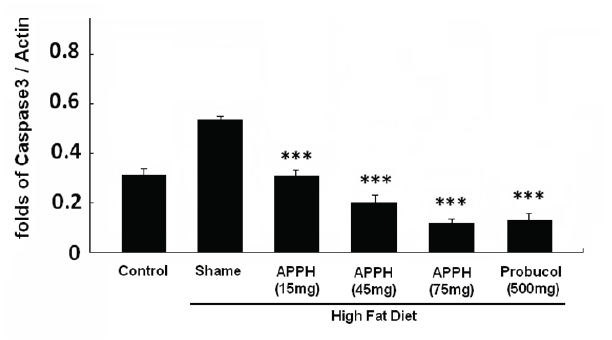
Figure 3. Fas-induced apoptosis pathway signaling analysis. All protein samples from each rat group were analyzed by Western blotting ( n = 3). The protein expression folds were normalized with β -actin. * p < 0.05, ** p < 0.01, *** p < 0.001 compared with the HFD (high-fat diet)